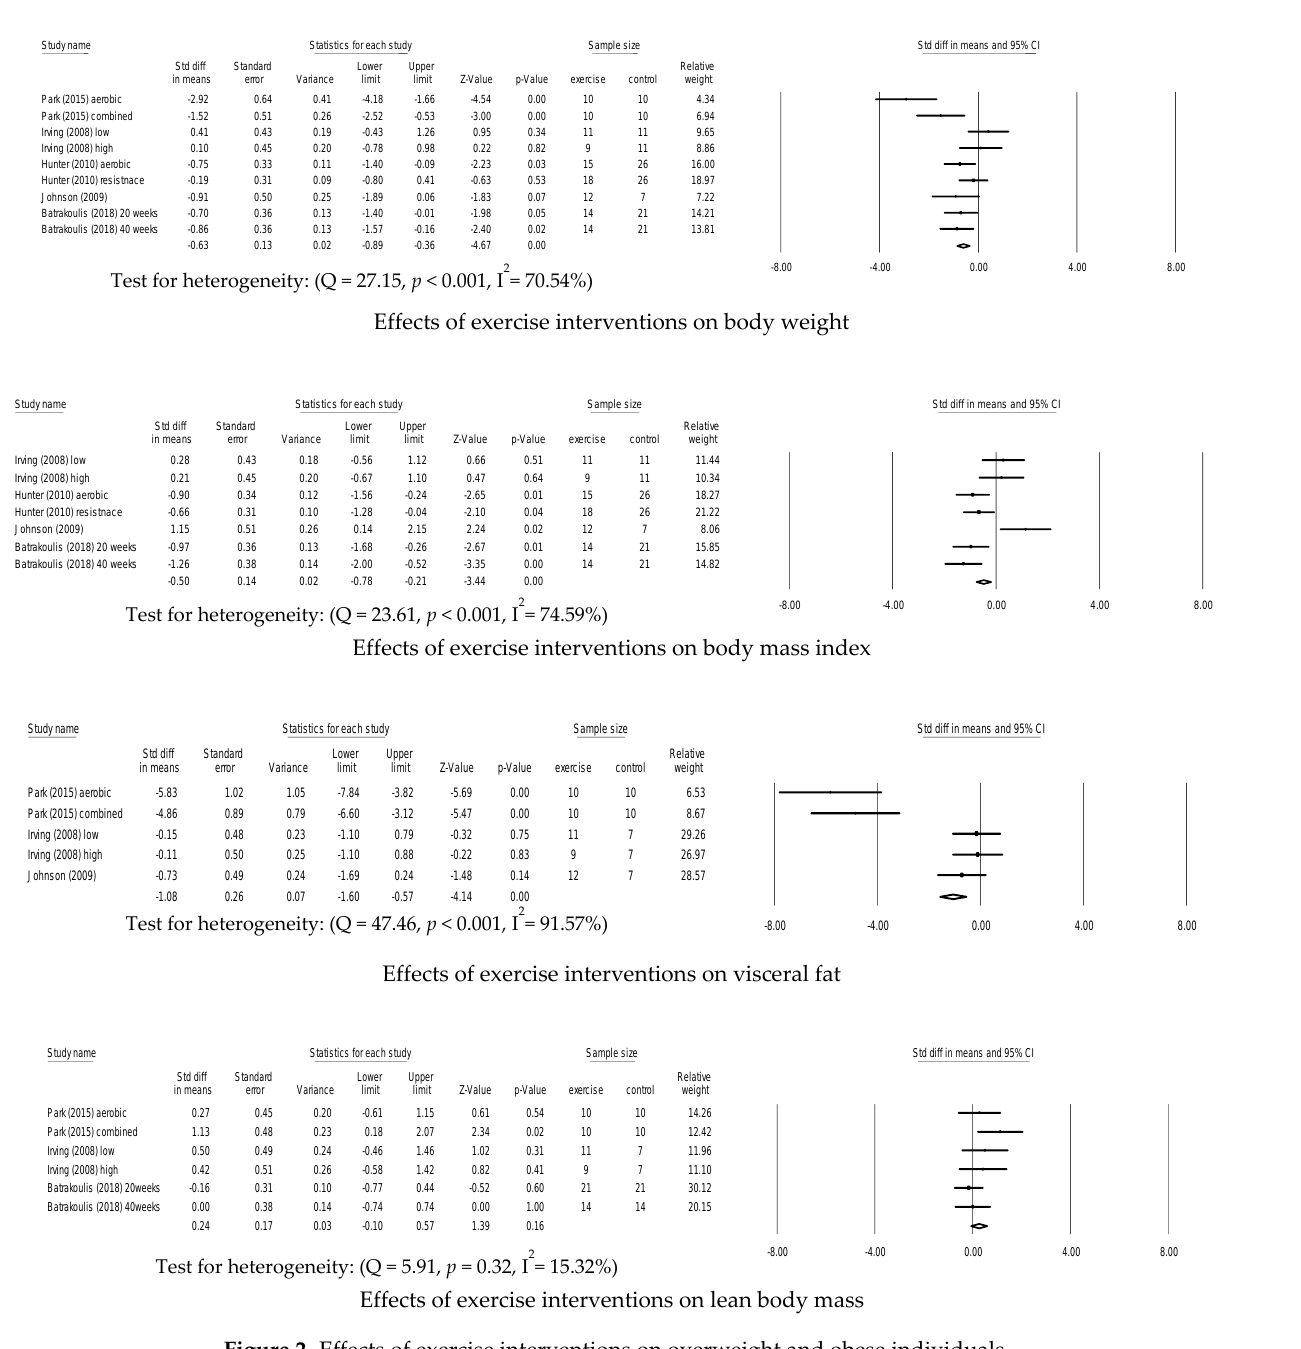
Figure 2. Effects of exercise interventions on overweight and obese individuals